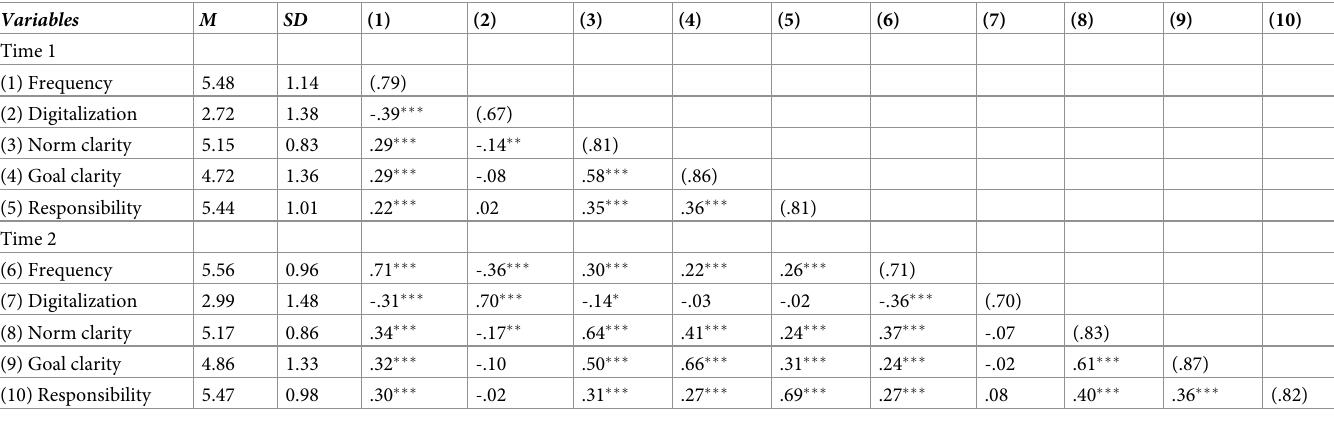
Table 3. Means, standard deviations, correlations (Pearson’s r), and Cronbach’s α (in brackets) on the diagonal of Study 2 ( N = 305). Variables